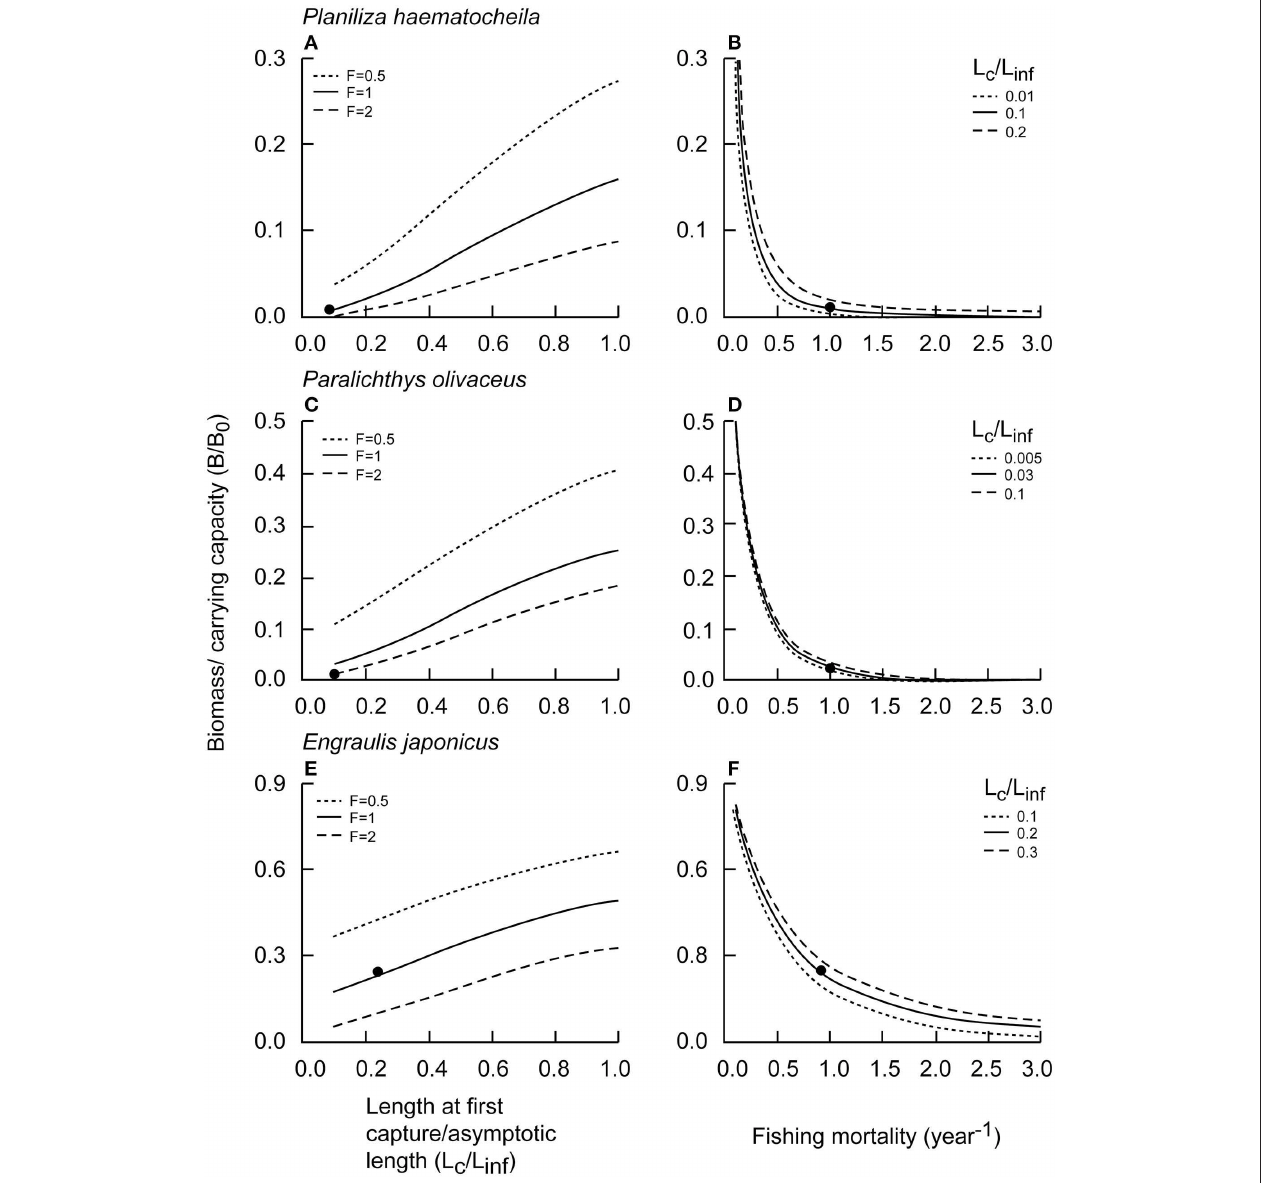
FIGURE 5 | Relative biomass ( B/B 0 ) under different L c and F in China’s coastal seas; respectively; the black dots represent current relative biomass levels. (A) P. haematocheila B/B 0 vs. L c / L inf . (B) P. haematocheila B/B 0 vs. Fishing mortality. (C) P. olivaceus B/B 0 vs. L c / L inf . (D) P. olivaceus B/B 0 vs. Fishing mortality. (E) E. japonicus B/B 0 vs. L c / L inf . (F) E. japonicus B/B 0 vs. Fishing